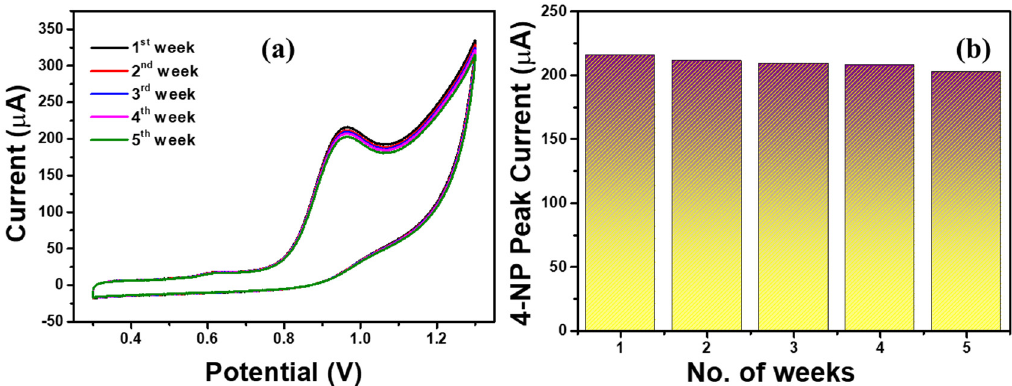
Figure 11. ( a ) Stability responses of Ag-ZnO/GCE ( b ) Ag-ZnO/GCE electrode response current in 500 µM 4-NP containing 0.1 M PBS (pH = 7) solution. (Accumulation time: 2 min, catalyst loading volume: 10 µL).